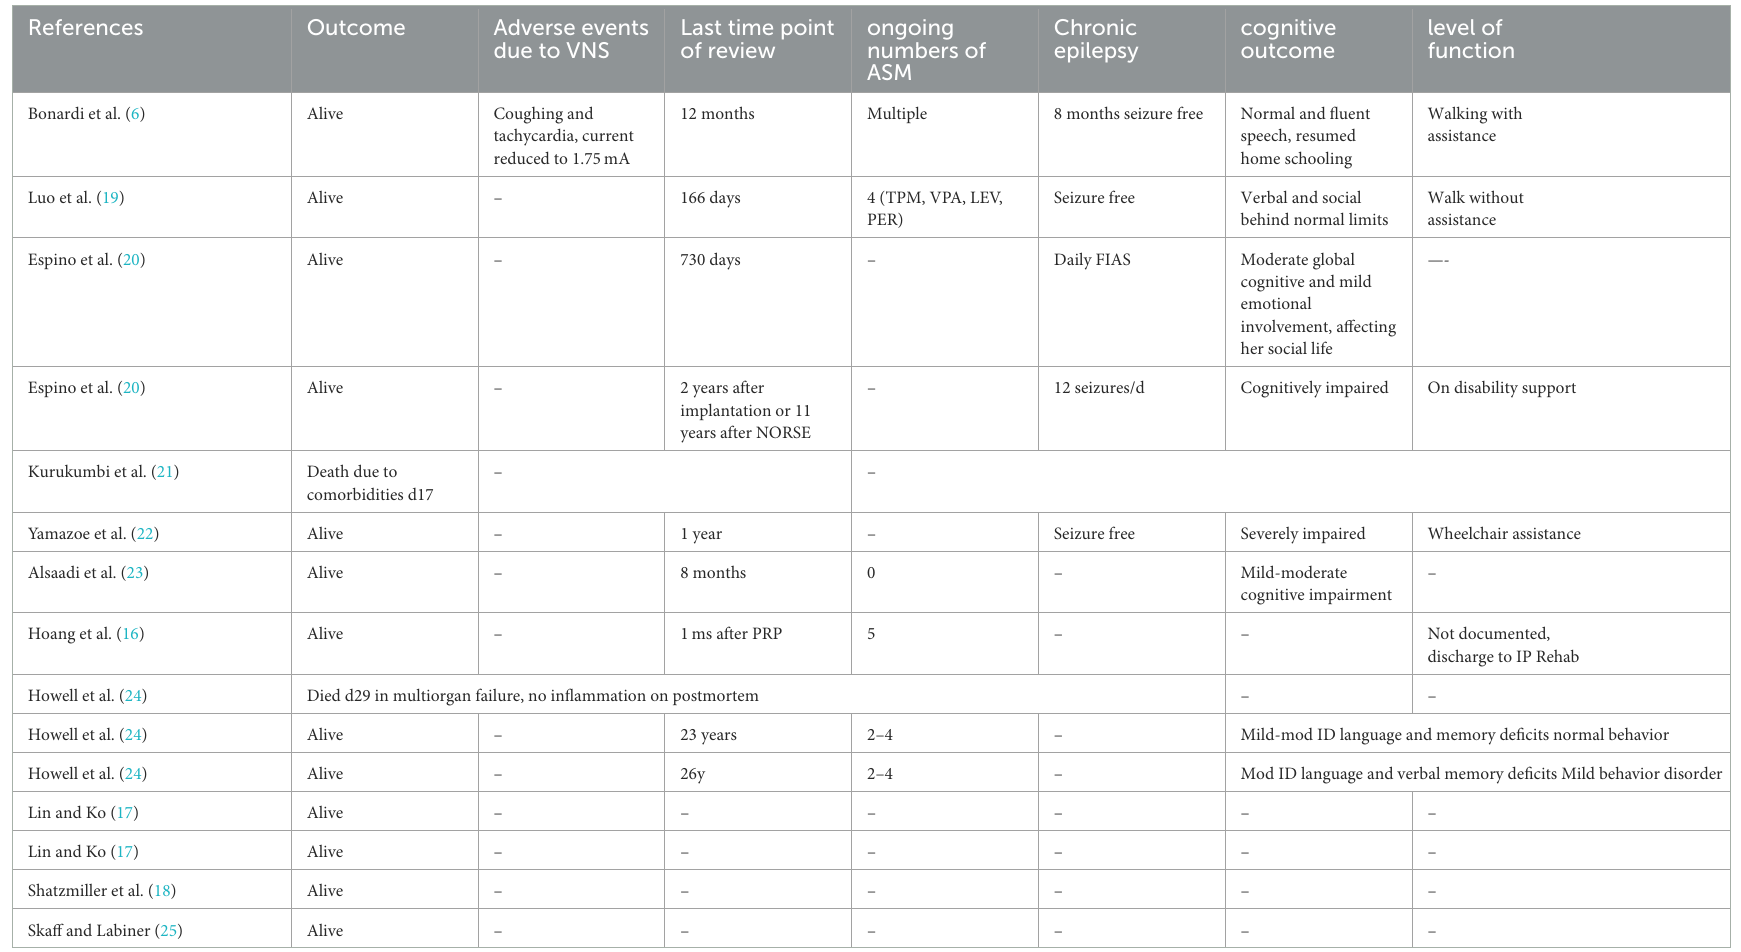
TABLE 2 Summary of outcomes in published NORSE cases treated with